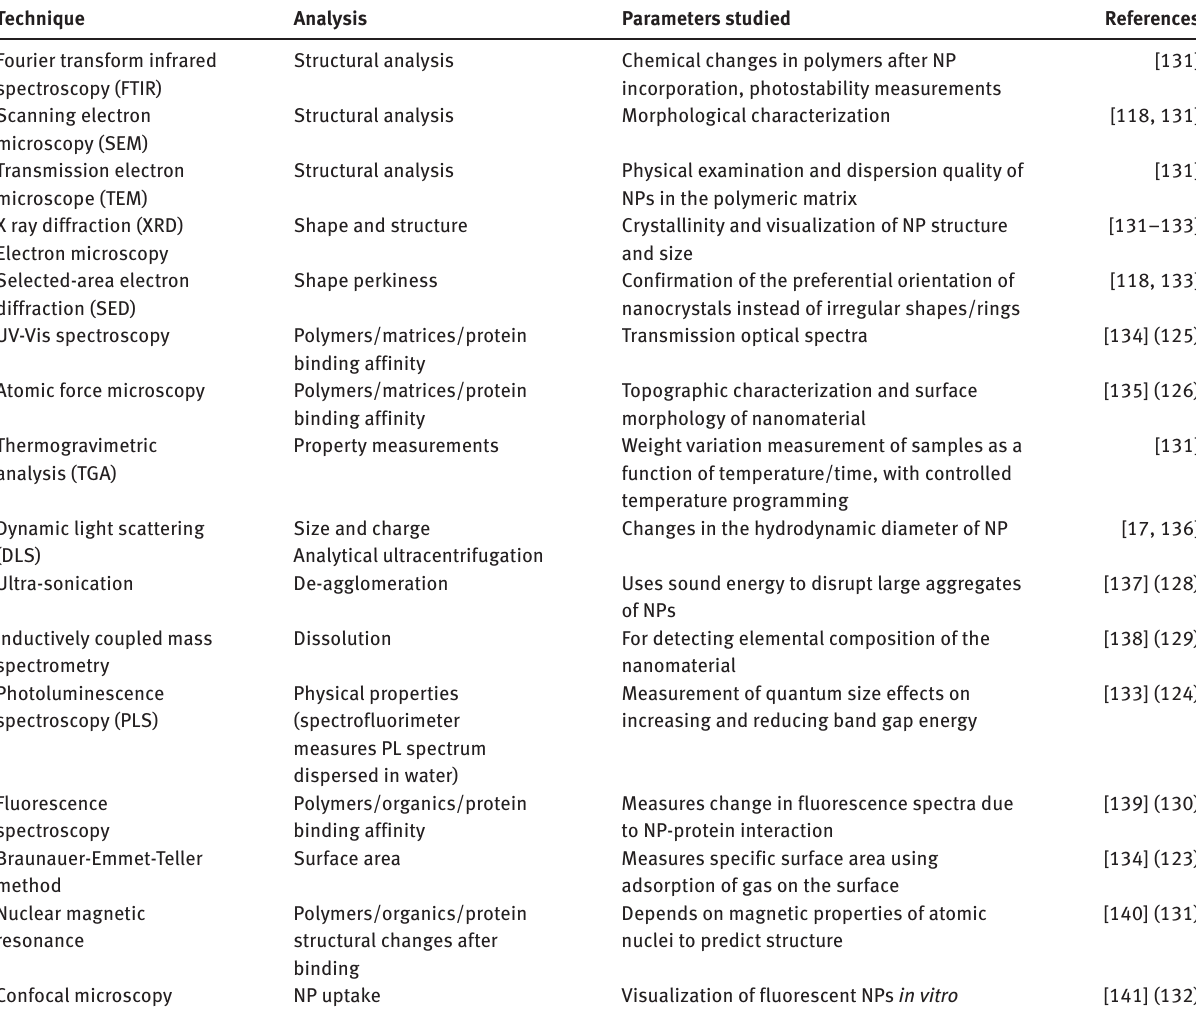
Table 4: Summary of analytical techniques to conduct physicochemical characterization and monitoring of ZnO NPs (in living systems